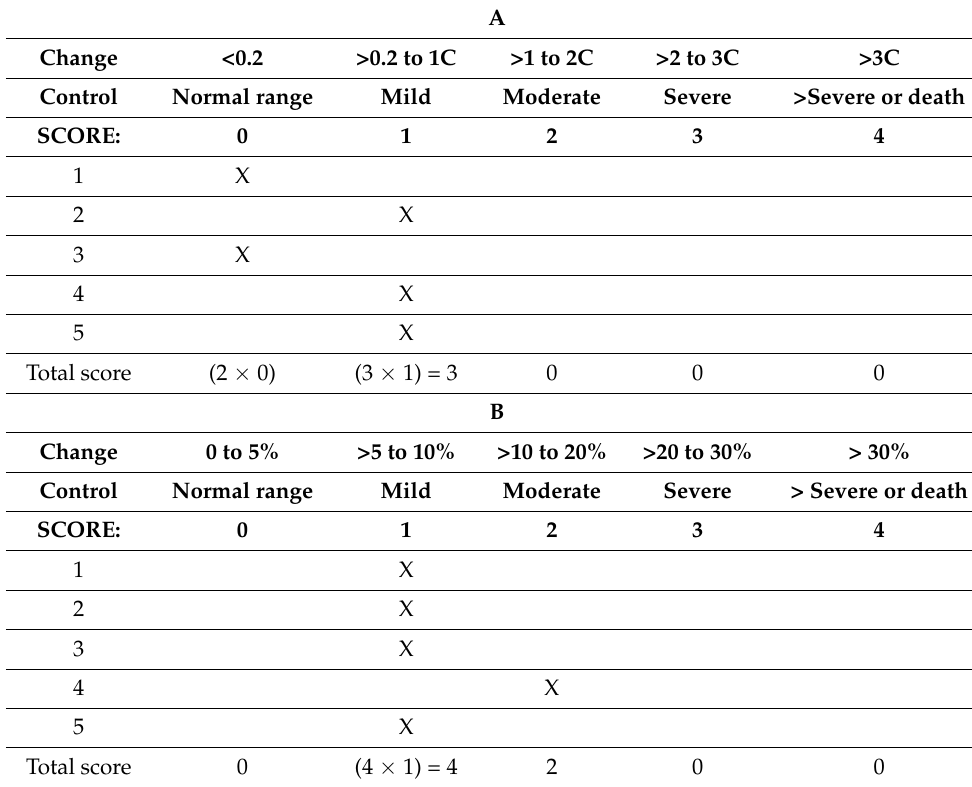
Table 1. (A) The proposed scoring matrix for body temperature (low dose). (B) The proposed scoring matrix for body weight (low dose).